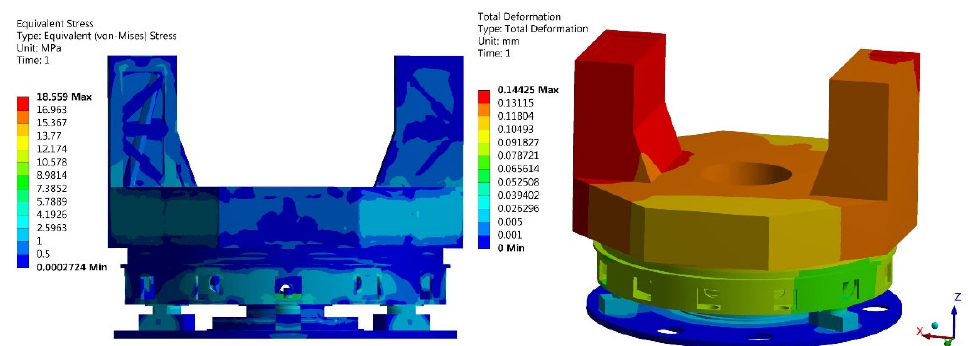
Figure 12. Stress and deformation nephogram of the optimized model.